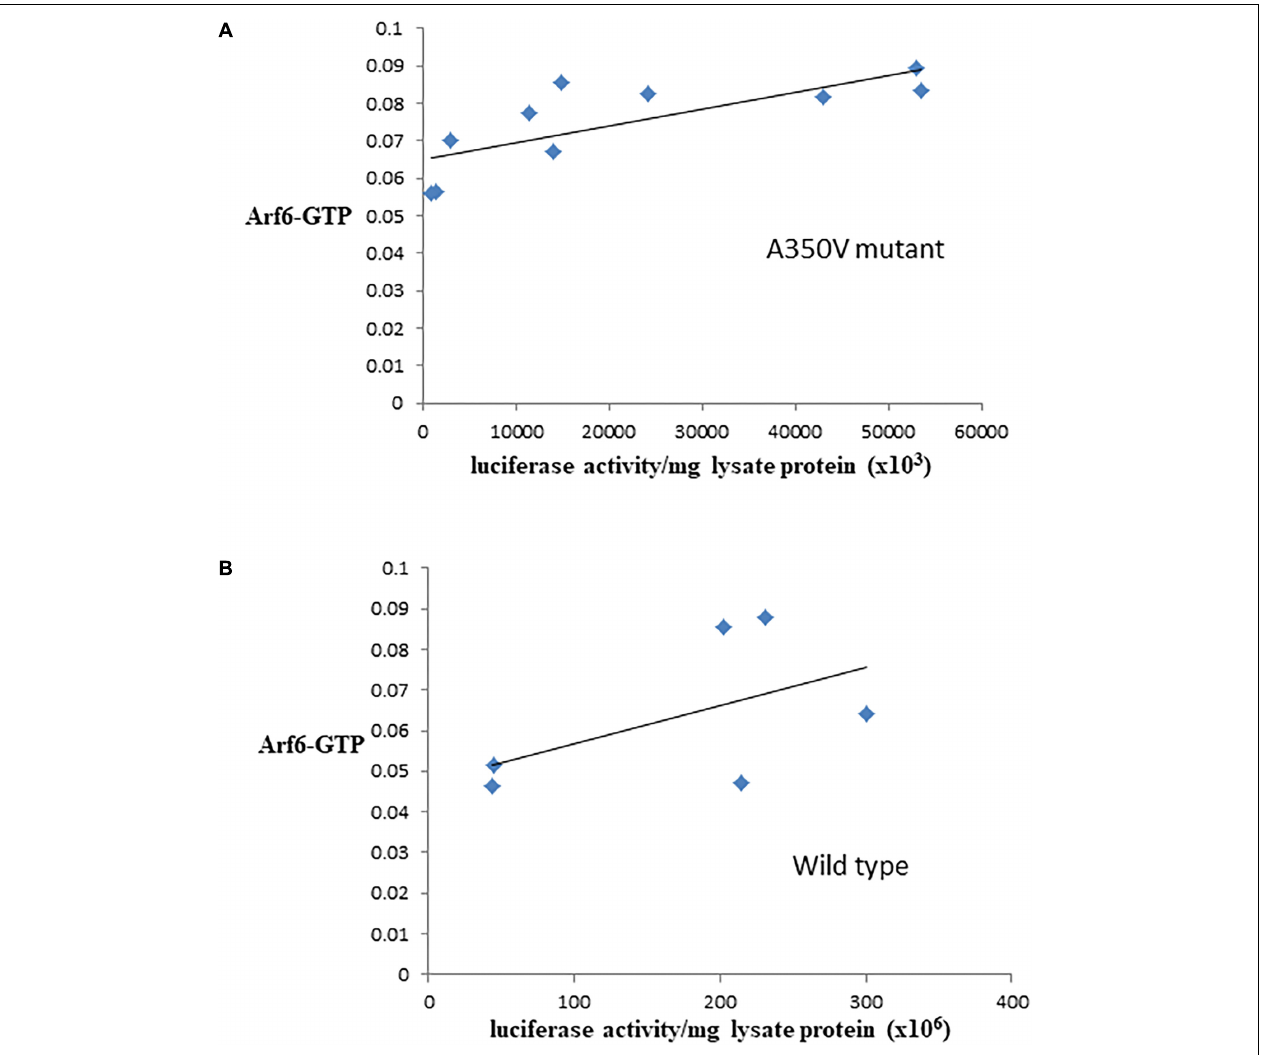
FIGURE 3 | Correlation between Arf6-GTP and luciferase in cell lines producing A350V (A) or wild type (B) IQSEC2 luciferase. Arf6-GTP was measured by ELISA (spectrophotometric units). The correlation between the relative amount of IQSEC2 and Arf6-GTP was significant for A350V ( r = 0.77, n = 10, p = 0.009) but not for WT IQSEC2 ( r = 0.52, n = 6, p = 0.28).